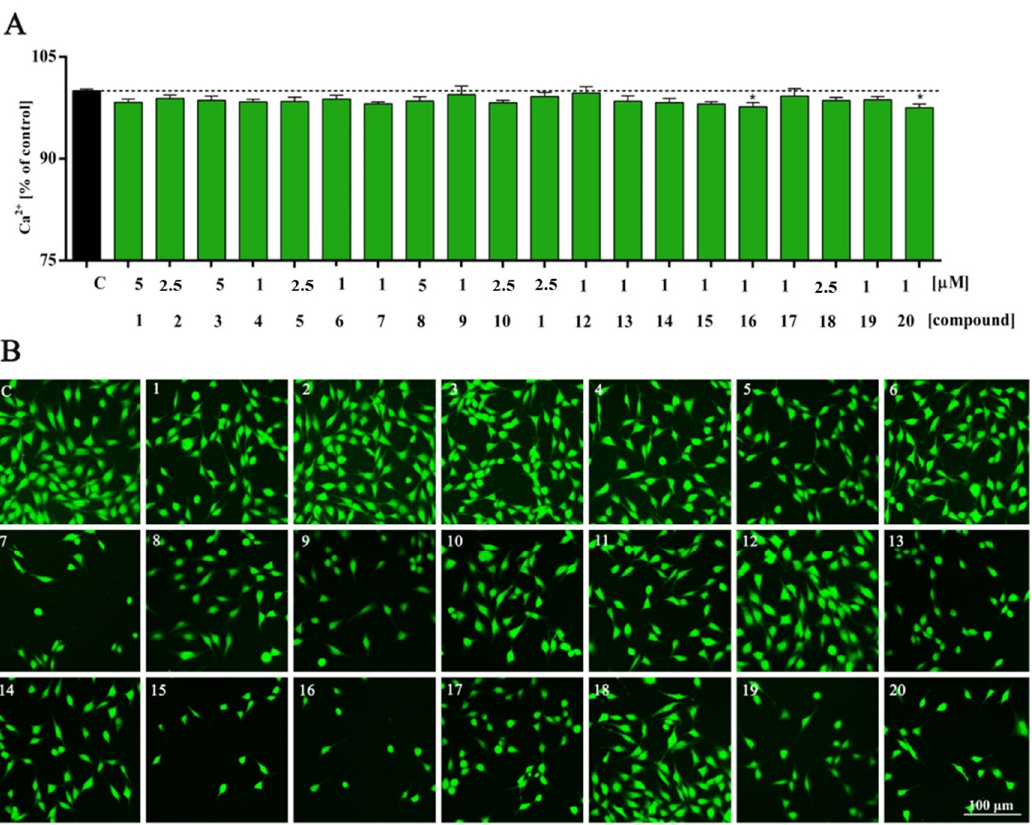
Figure 3. Intracellular calcium (Ca 2+ ) level of HT-22 cells treated with compounds 1–20 ( A ) for 48 h and representative images ( B ). All experimental groups were compared using one-way ANOVA of variance with Dunnett’s post hoc test; mean ± SD, n = 9. Statistically significant results are dis- played as: * p < 0.05. Green fluorescence—FITC. Magnification of the objective lens 10×.